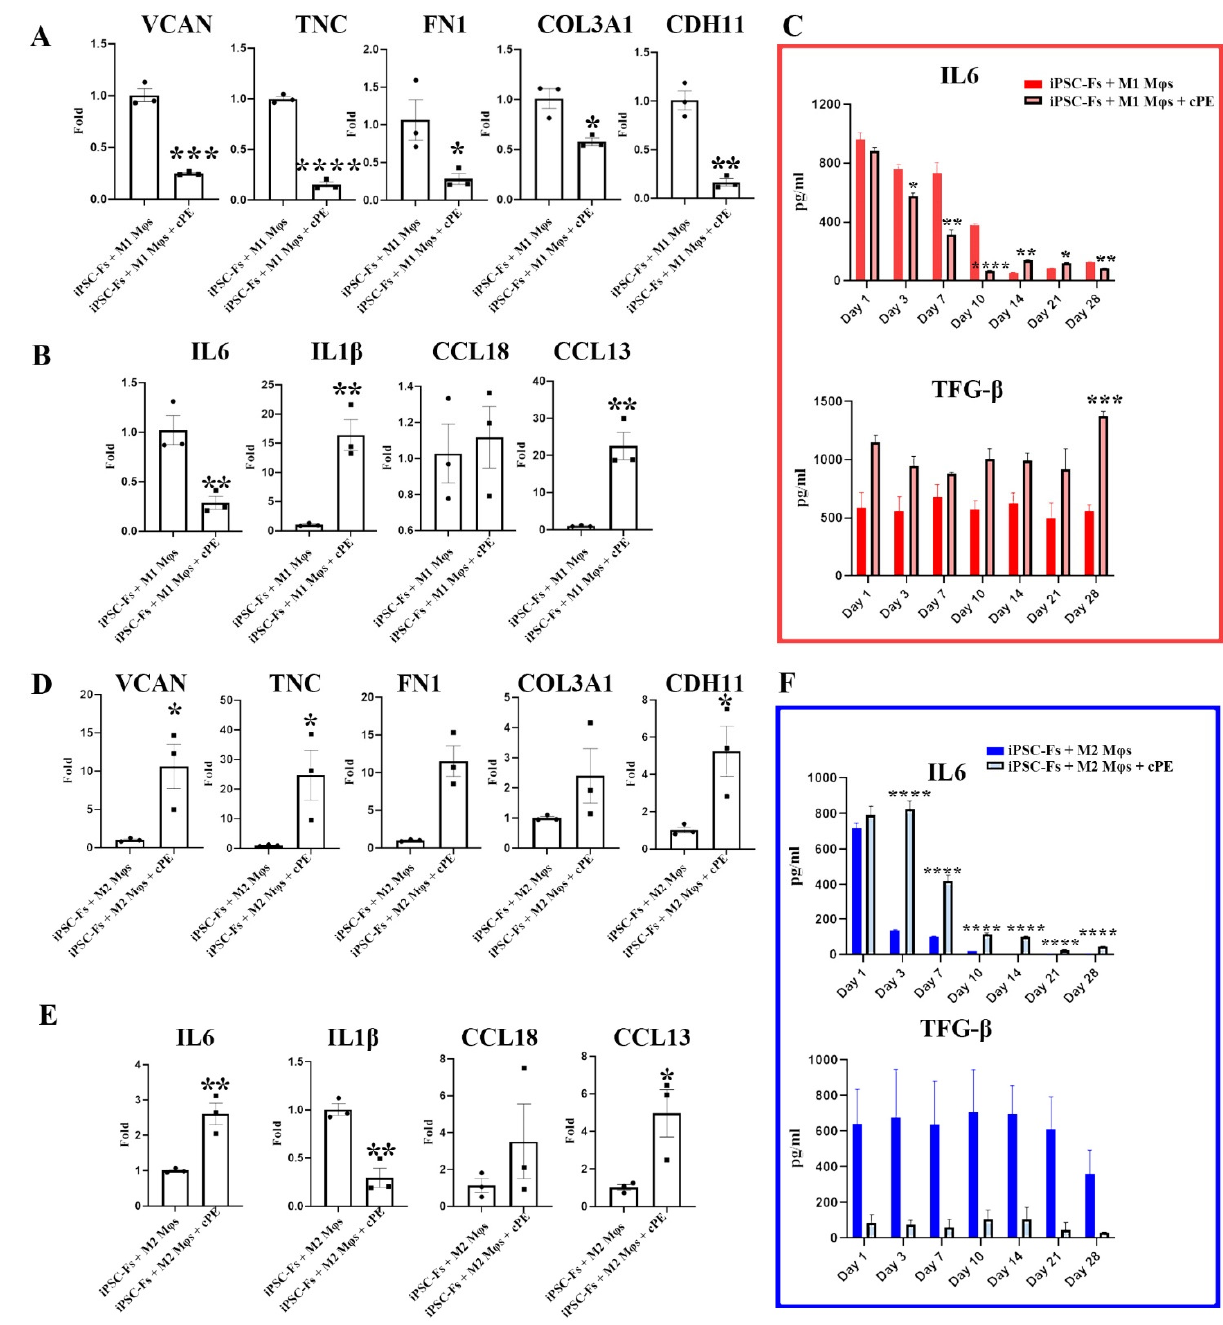
Figure 5. Impact of polyethylene particles on iPSC-Fs. Comparison of expression levels of ( A ) fibroblast-associated genes and ( B ) inflammation-related genes in the iPSC-Fs and M1 M ϕ co-culture system. ( C ) Cytokine profile of the M1 co-culture system. Comparison of expression levels of ( D ) fibroblast-associated genes and ( E ) inflammation-related genes in iPSC-Fs and M2 M ϕ co-culture system. ( F ) Cytokine profile of the M2 co-culture system. (* p < 0.05, ** p < 0.01, *** p < 0.001, **** p < 0.0001) (values are ±SEM).